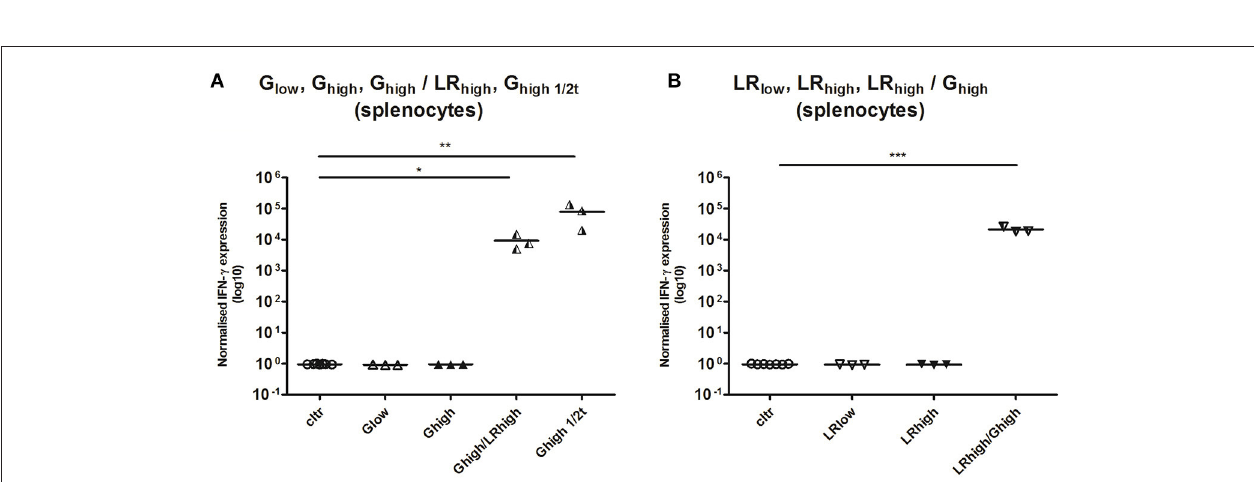
FIGURE 7 | Relative normalized IFN- γ expression in splenocytes after a single or consecutive IPB-G and IPB-LR inoculation. Splenocytes were isolated from pigs orally infected with (A) a low dose of the IPB-G strain (G low ), a high dose of the IPB-G strain (G high ), a high dose of the IPB-G strain followed 60 days later by a high dose of the IPB-LR strain (G high /LR high ), a high dose of IPB-G at day 60 (G high1 / 2t ), or (B) a low dose of the IPB-LR strain (LR low ), a high dose of the IPB-LR strain (LR high ) or a high dose of the IPB-LR strain followed 60 days later by a high dose of the IPB-G strain reversed infection model (LR high /G high ). Cells were isolated at 2 mpi (group: G high1 / 2t ) or 4 mpi (groups: G low , LR low , G high , LR high , G high /LR high , LR high /G high ) and restimulated in vitro with TLA. IFN- γ mRNA was quantified with RT-PCR. The thick lines indicate the group mean. The significance level: * P < 0.05, ** P < 0.01; *** P < 0.001.